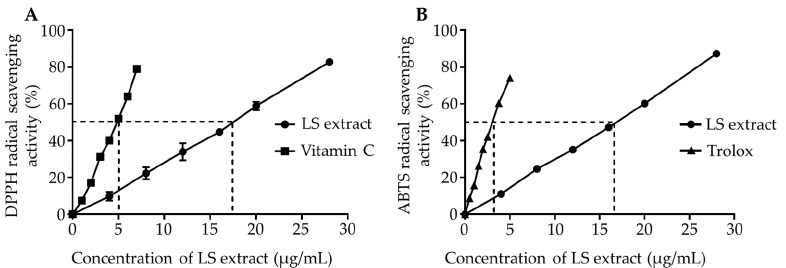
. Figure 1. Radical-scavenging activity of the Lasia spinosa (LS) leaf ethanol extract. Varying concentrations of LS leaf extract were mixed with 2,2-diphenyl-1-picrylhydrazyl (DPPH) ( A ) or 2,2-azino-bis(3-ethylbenzothiazoline-6-sulfonic acid) diammonium salt (ABTS) ( B ). Vitamin C and Trolox were used as positive controls in ( A ) and ( B ), respectively. After incubation, the absorbance at 517 nm in the DPPH assay or 734 nm in the ABTS assay was measured, and radical scavenging activity was calculated. The dotted line indicates the concentration of LS leaf extract or control substance which is required for 50% radical scavenging (SC 50 ). Data are expressed as means ± SD. Significant di ff erences between the LS leaf extract and vitamin C or Trolox controls ( n = 3) were evaluated by t -test. Int. J. Mol. Sci. 2020 , 20 , x FOR PEER REVIEW